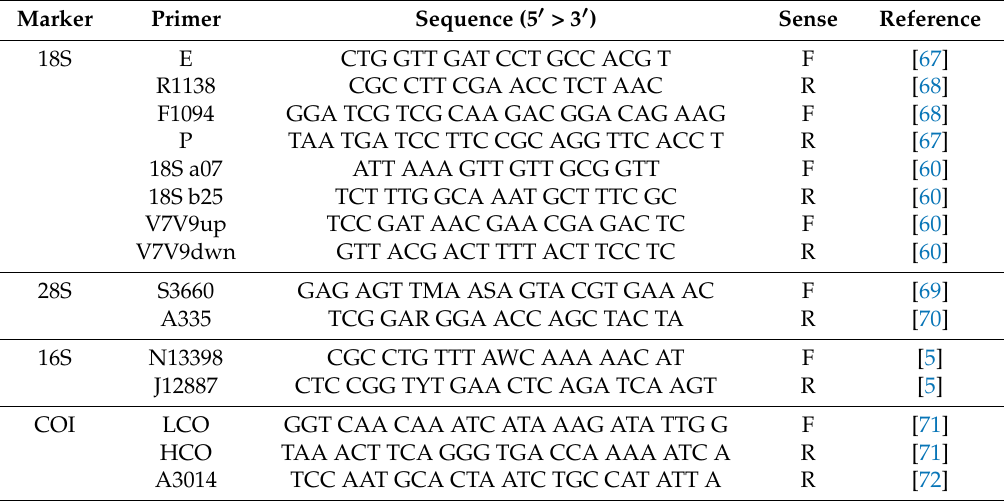
Table 2. List of primers used for PCR amplification and sequencing of the markers used in the phylogenetic analyses of Entiminae.